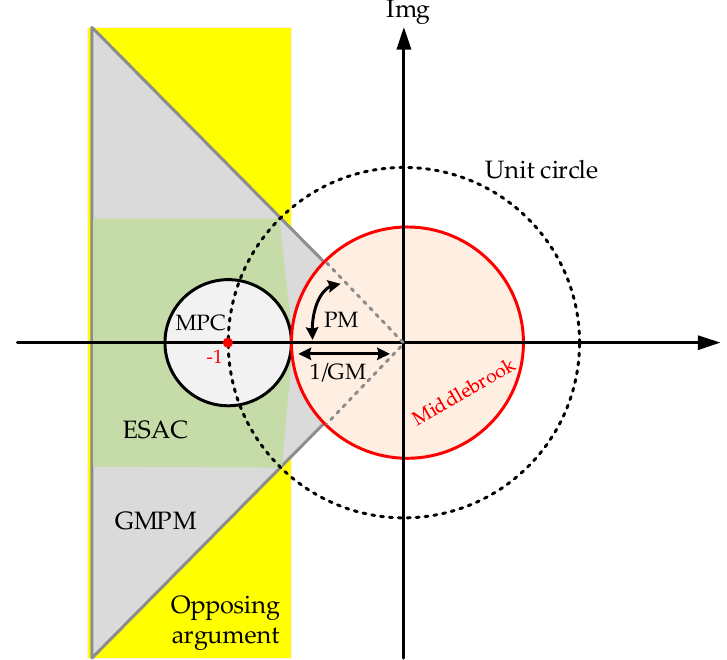
Figure 5. Stability Criteria boundaries [65].